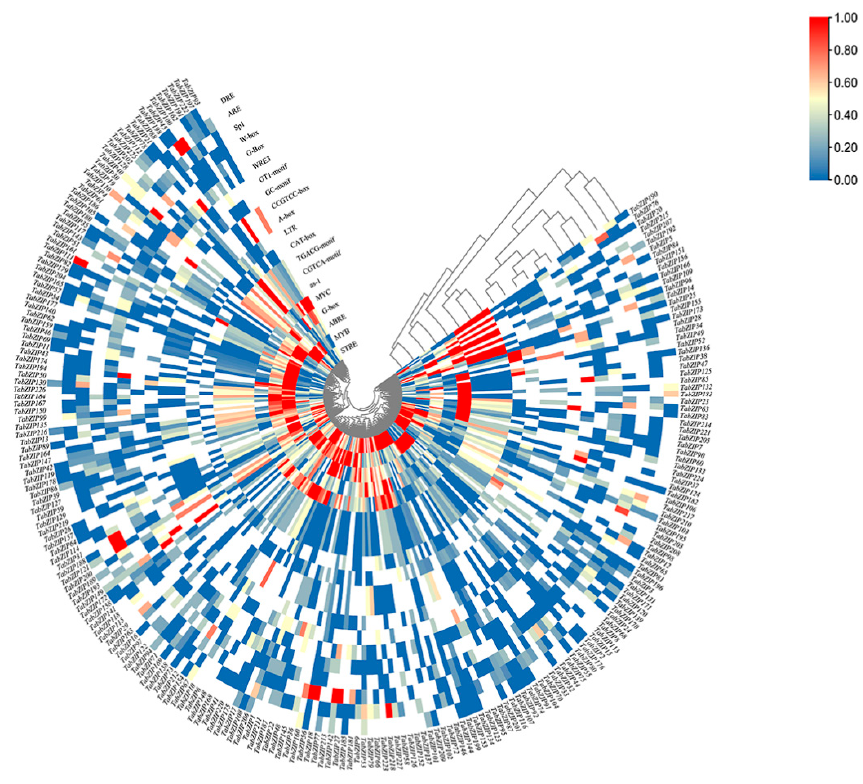
Figure 5. The cis-element of promoter in TabZIP gene family. The depth of the color represents the number of times the cis-element occurs.